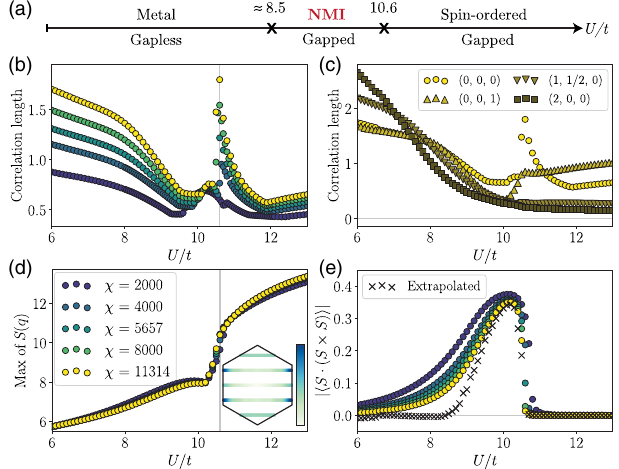
FIG. 3. Results for the YC4 cylinder. Results are shown for a range of MPS bond dimensions χ as indicated in the lower left legend. (a) A nonmagnetic insulating (NMI) phase appears between a gapless metallic phase at low U=t and a magnetic phase at high U=t . (b) Correlation length in the “ charge neutral sector, ” in other words for excitations carrying no charge, spin, or momentum. The vertical line at U=t ¼ 10 . 6 is provided as a guide to the eye. (c) Correlation lengths at the largest bond dimension in various charge sectors. The sector ð Q; S; K Þ corresponds to correlations h O 1 O 2 i , where O 1 creates and O 2 annihilates an excitation carrying charge Q , spin S , and momentum quantum number K . (d) Spin structure factor: the curve shows the maximum value of the spin structure factor in the Brillouin zone. The inset shows the spin structure factor in the high- U phase, with peaks at the closest allowed momenta to the K (cid:3) points, where they would be expected for 120° magnetic ordering. Note that spin expectation values are reported here and through- out the paper with ℏ = 2 ¼ 1 . (e) Chiral order parameter h S i · ð S j × S k Þi , where i , j , and k label the three vertices of a triangle in the lattice, with an additional line showing extrapo- lation in the DMRG truncation error [66]; see Supplemental Material [56] for details on the